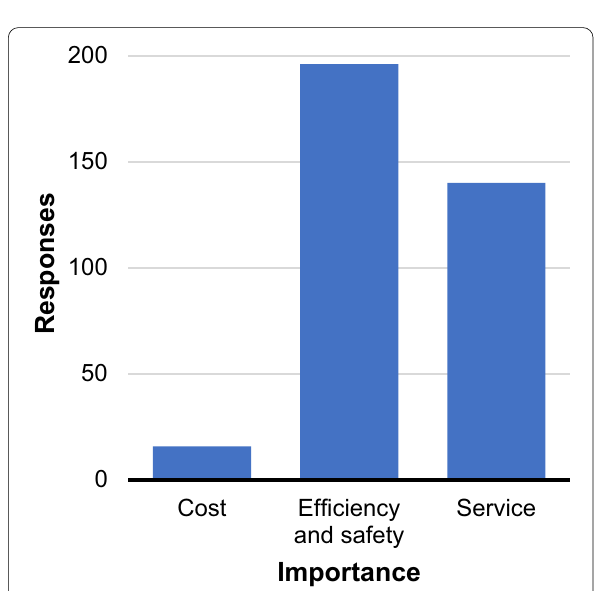
Fig. 11 Perceived most important aspect of value in